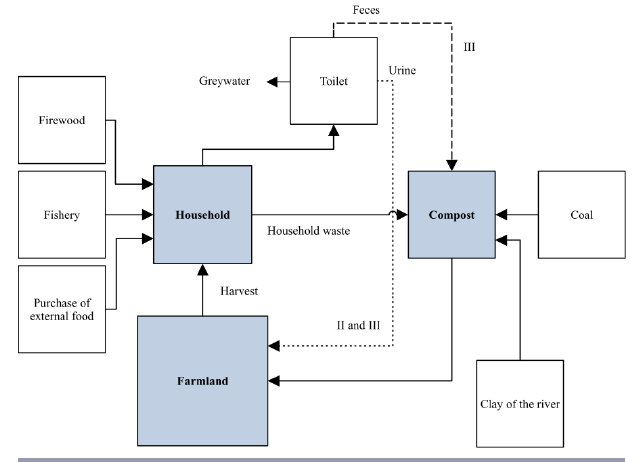
Fig. 3 . Scenarios I, II, and III: As input to the household are shown the nutrients from the farmland and the external input of nutrients to the household by the forest, the fishery, and the purchase of external food (given by neighbors or bought as groceries). All household waste with the exception of human excreta are proposed to be composted with coal and river clay. Part of these scenarios is the input of wood for cooking and coal production with external wood, as is customary in Sarayaku. Although in scenario I no human excreta is recycled, scenario II involves human urine (dotted line) and scenario III, both human urine and feces (dashed and dotted